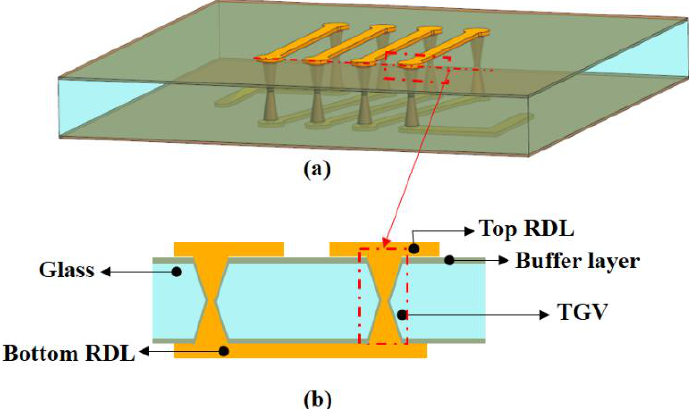
Figure 10. ( a ) FE model of B structure. ( b ) Cross-sectional image of B structure.